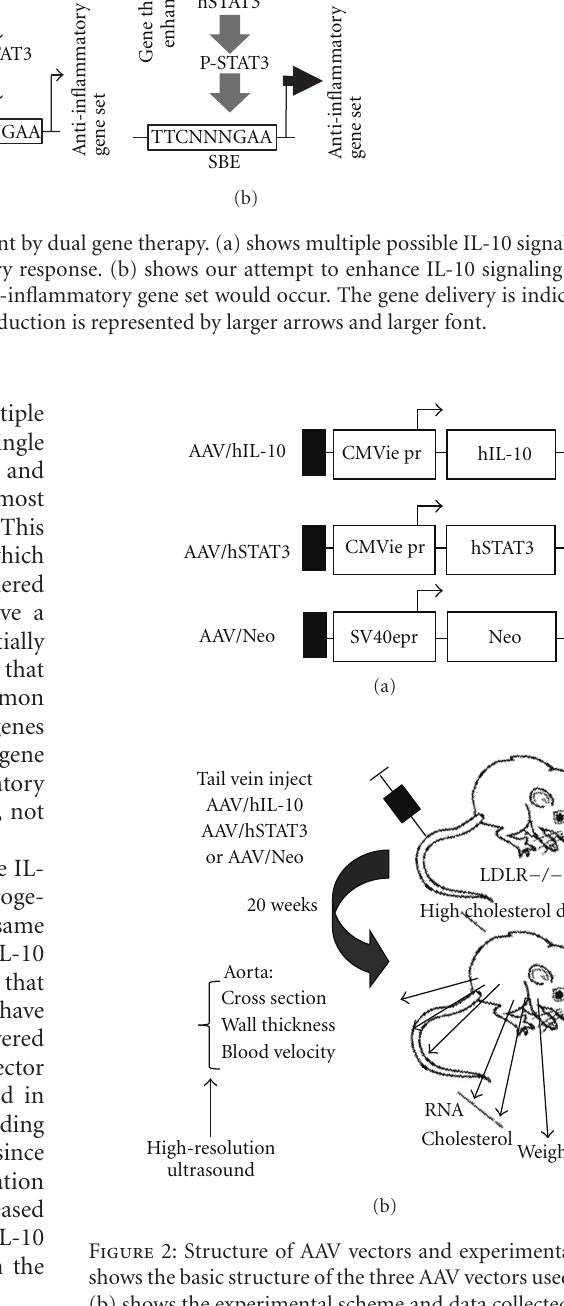
The virus stocks were generated and tittered by dot blot hybridization as described previously [4, 7, 9]. The titers were calculated to be about 1 × 10 9 encapsidated genomes per mL